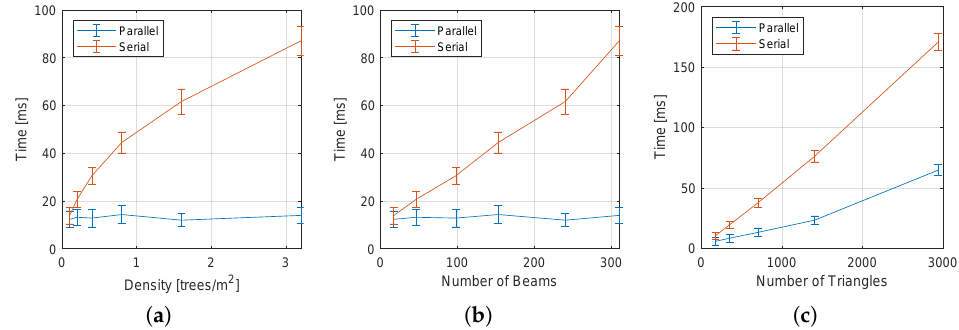
Figure 15. Effect of the lattice parameters and environment density on total planning time for both the serial and parallel implementation of the method. ( a ) Effect of the density of the forest; ( b ) effect of the number of laser beams; ( c ) effect of the number of